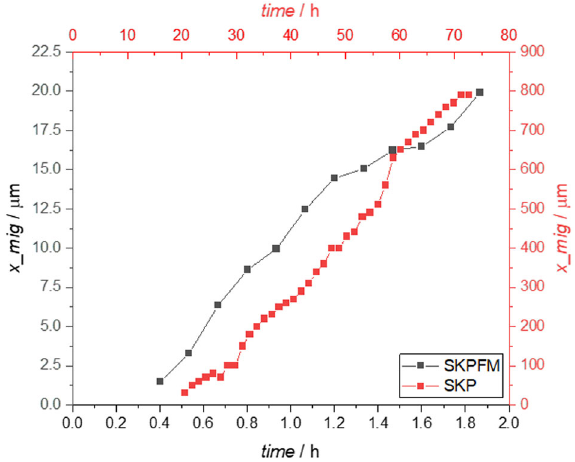
Fig. 11 SKP vs. SKPFM comparison. Position of the front of migration ( x_mig ) vs. time obtained from the scanning Kelvin probe (SKP) and scanning Kelvin probe force microscopy (SKPFM) measurements during cathodic electrolyte spreading on